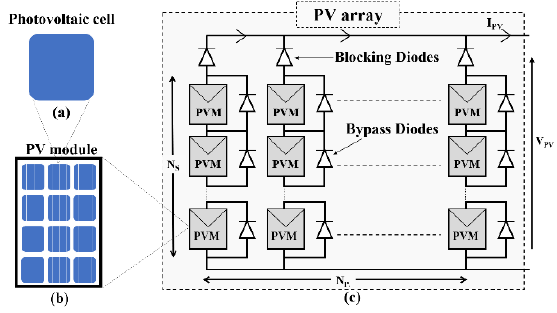
Fig. 5. Photovoltaic array.